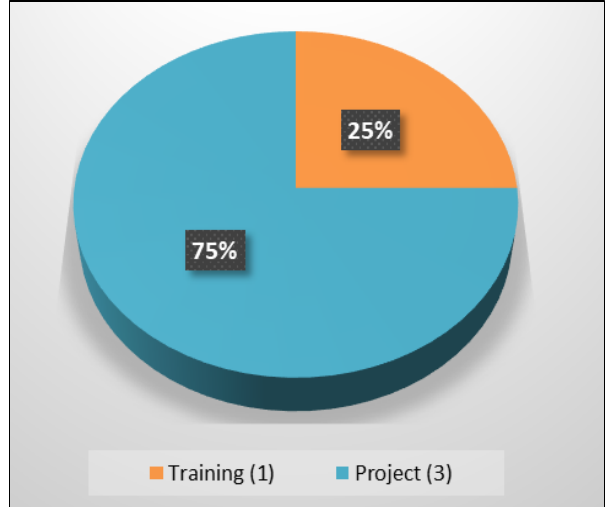
Figure 3: Classification of No-Conformed (NC).